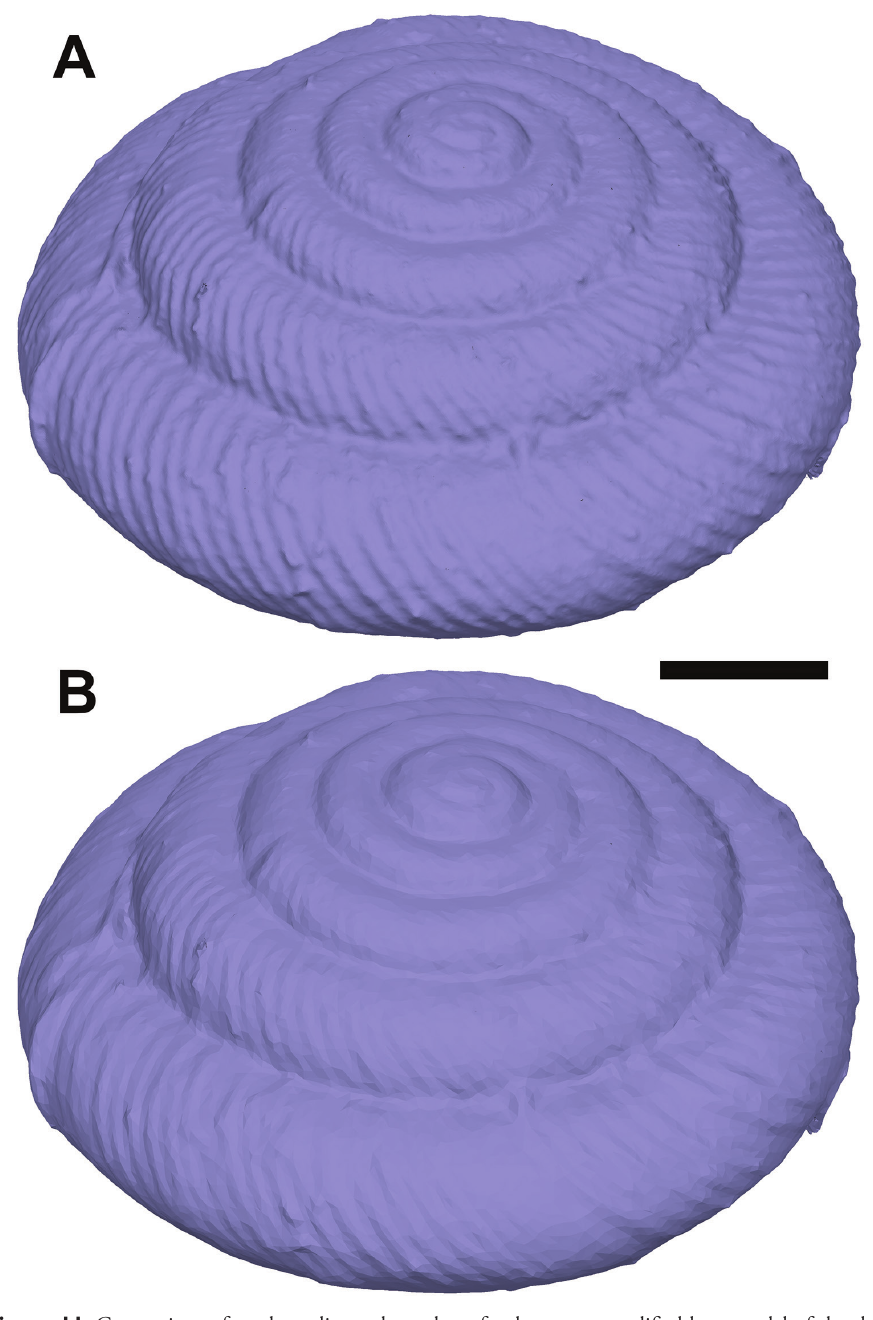
Figure 11. Comparison of mesh quality and number of polygons, exemplified by a model of the shell of Discus rotundatus . The model with 1 million faces ( A ) has a file size (3D-PDF) of 35 MB and shows more detail, but the reduced model with 75.000 faces ( B ) still well resembles the structure with a file size (3D-PDF) of only 3